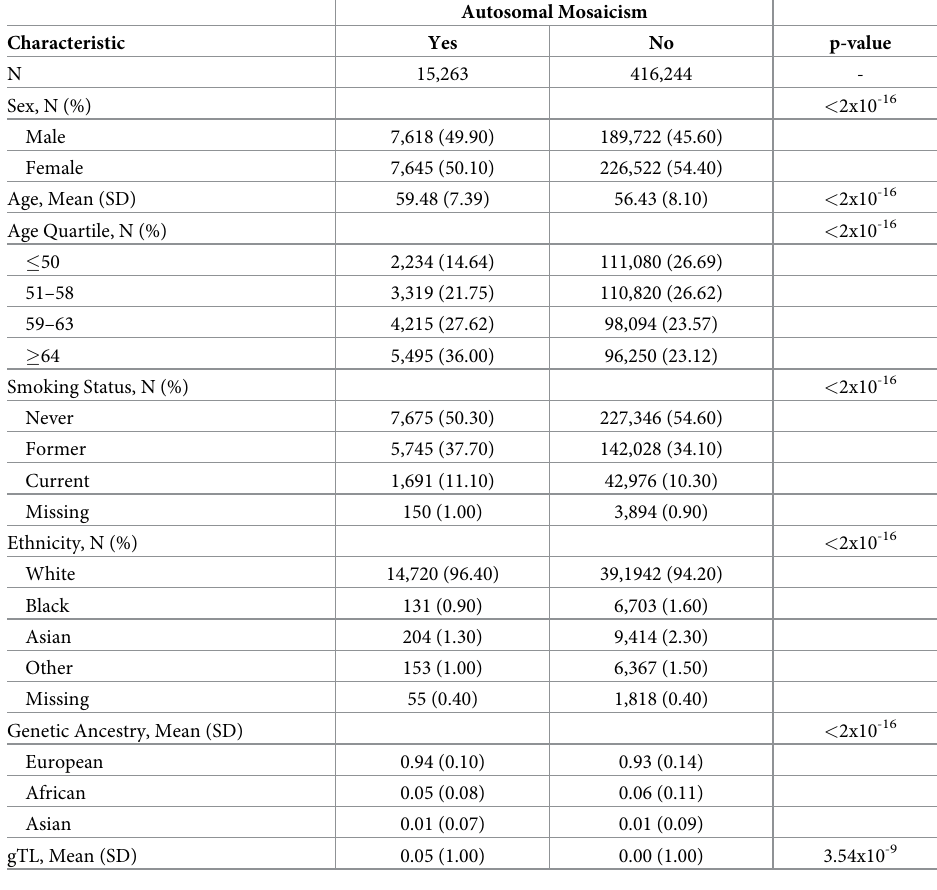
Table 2. UK Biobank population characteristics by autosomal SCNAs status. Autosomal Mosaicism Characteristic Yes No p-value (White: OR = 1.07, 95% CI = 1.06–1.09, P < 2 × 10 − 16 , P = 0.1484; S3 Table ). Similar positive het associations were also observed between specific individual telomere length-associated SNPs and the odds of autosomal SCNAs ( Fig 1 and S4 Table ). Of the 20 telomere length-associated variants included in our derived PRS, six variants (rs2293607, rs7705526, rs2488002, rs78517833, rs11846938, and rs28616016) displayed evidence for an individual association with SCNA ( p < 0.05). For all the telomere length-related variants associated with SCNAs, the allele related to longer telomere length was associated with an increased odds of developing SCNAs. Mendelian randomization (MR) analyses further indicated a directionality between telomere length-associated variants and SCNA ( S5 Table, S6 Table and S3 Fig). After remov- ing detected heterogeneous variants, the intercept from MR-Egger regression was non-signifi- cant (P = 0.2375), suggesting no significant evidence for directional pleiotropy on the remaining variants. The maximum-likelihood based method predicted an increasing effect between the telomere length genetic instrument and the odds of SCNAs (OR = 1.72, 95% CI = 1.48–2.00, P = 7.51 × 10 − 13 ; S6 Table ). Likewise, similar results were viewed across a vari- ety of MR methods ( S6 Table and S3 Fig). Further analyses stratified by chromosomal event location (telomeric, interstitial or whole chromosome events) and copy number state (gain, loss, neutral, or undetermined events) also